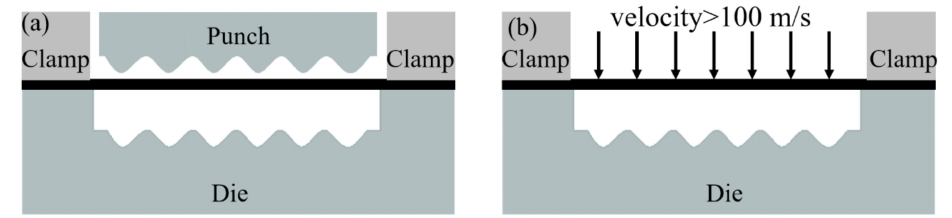
Figure 1. ( a ) A schematic of the experimental setup of traditional forming and ( b ) a schematic of the experimental setup of magnetic pulse